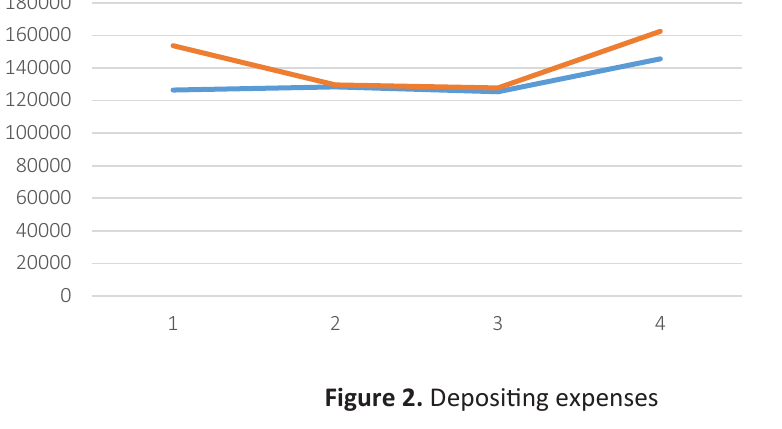
Figure 2. Depositing expenses